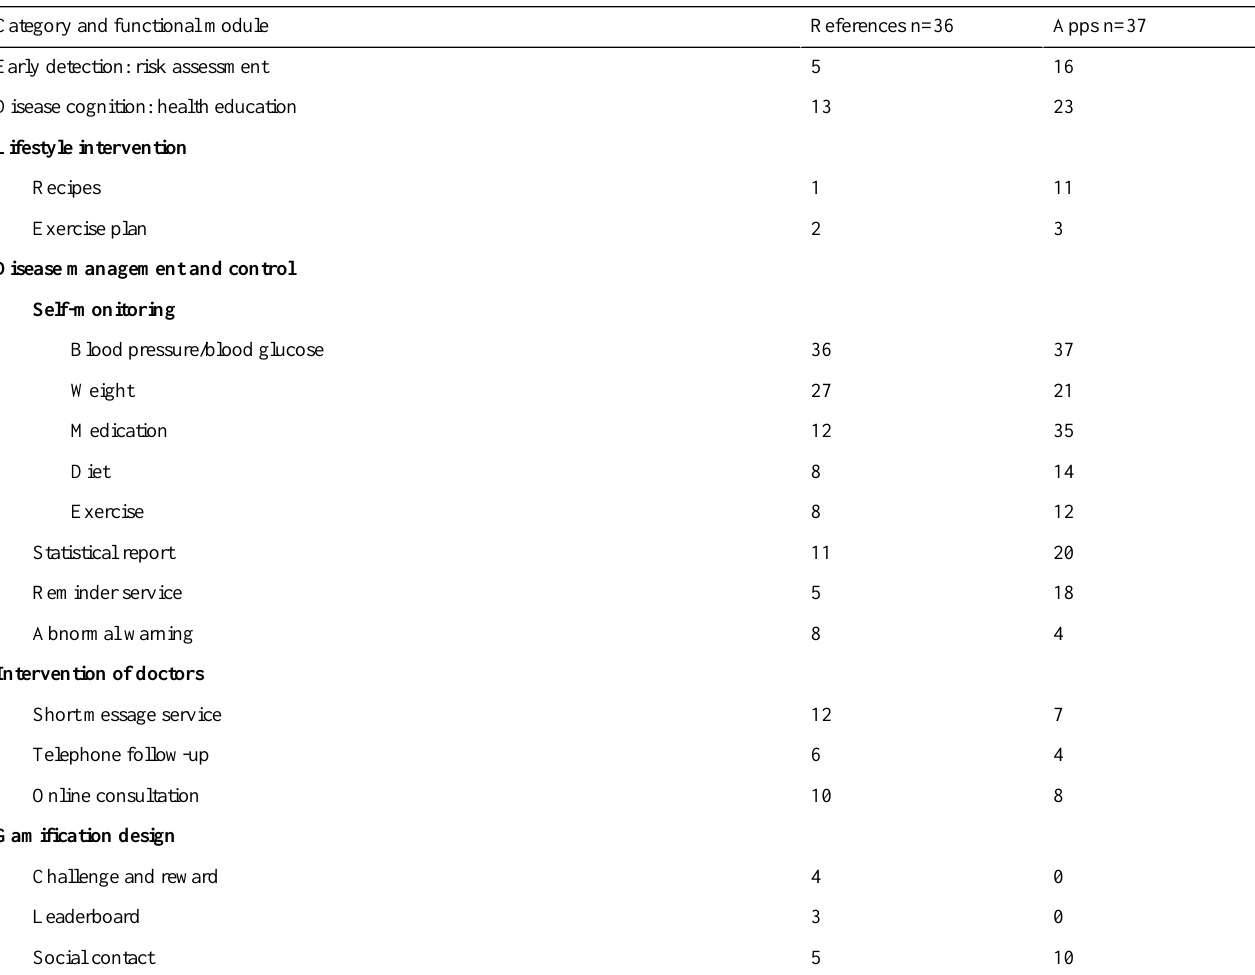
Table 5. Investigation results of functional modules in existing mHealth